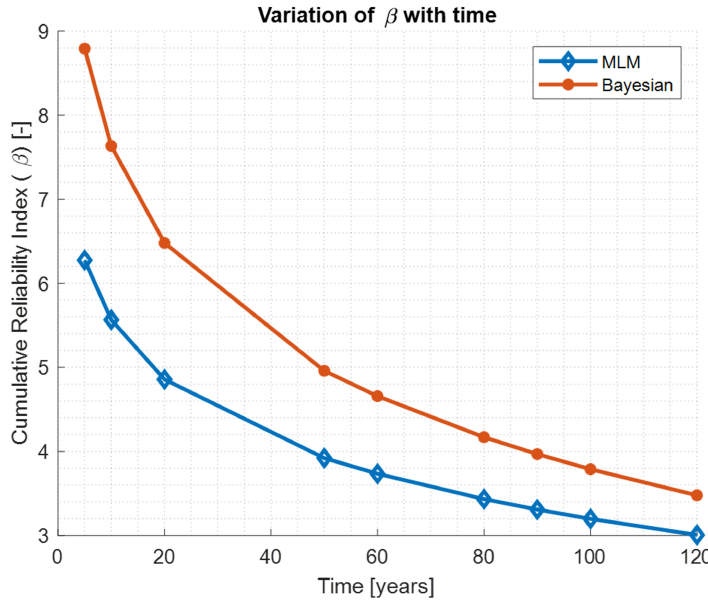
Figure 8. Reliability index as function of